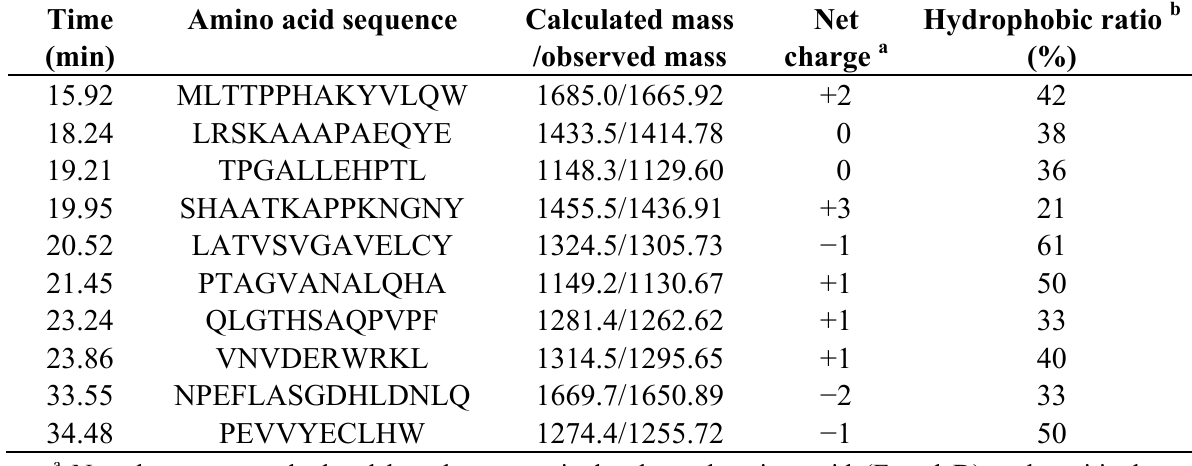
Table 1. Amino acid sequences of selected peptides in fraction HAHp2-3-I.